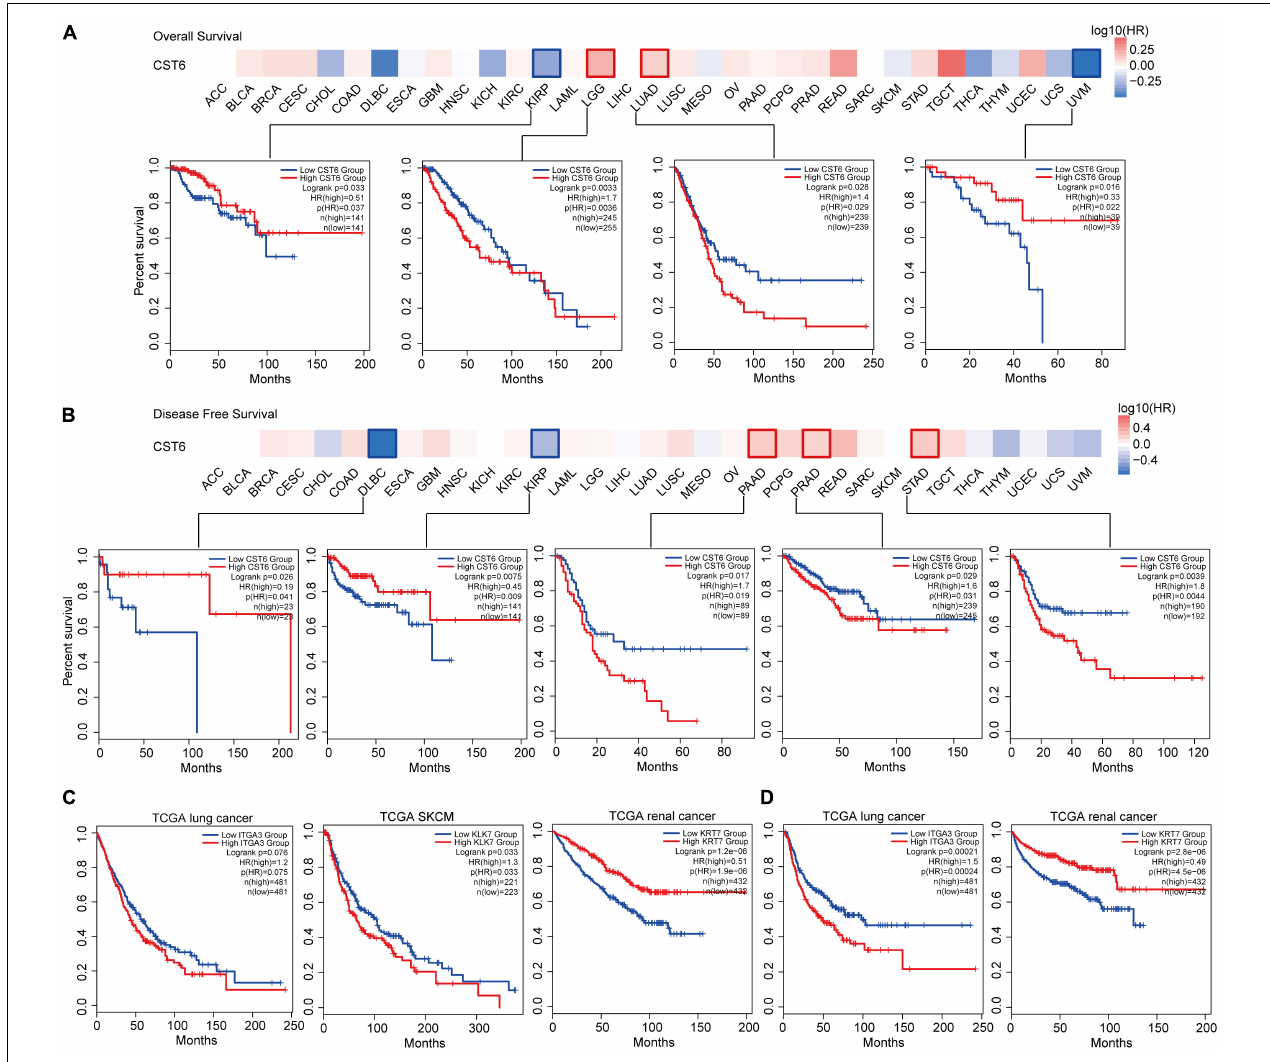
FIGURE 6 | Clinical association analysis between the expression of CST6 and survival prognosis across TCGA cancer types. (A) The survival map and Kaplan–Meier estimates of overall survival by CST6 expression in TCGA datasets. (B) The survival map and Kaplan–Meier estimates of disease-free survival by CST6 expression in TCGA datasets. (C) The Kaplan–Meier estimates of overall survival by ITGA3, KLK7, and KRT7 expression in TCGA lung cancer, melanoma, and renal cancer datasets. (D) The Kaplan–Meier estimates of disease-free survival by ITGA3 and keratin 7 (KRT7) expression in TCGA lung and renal cancer